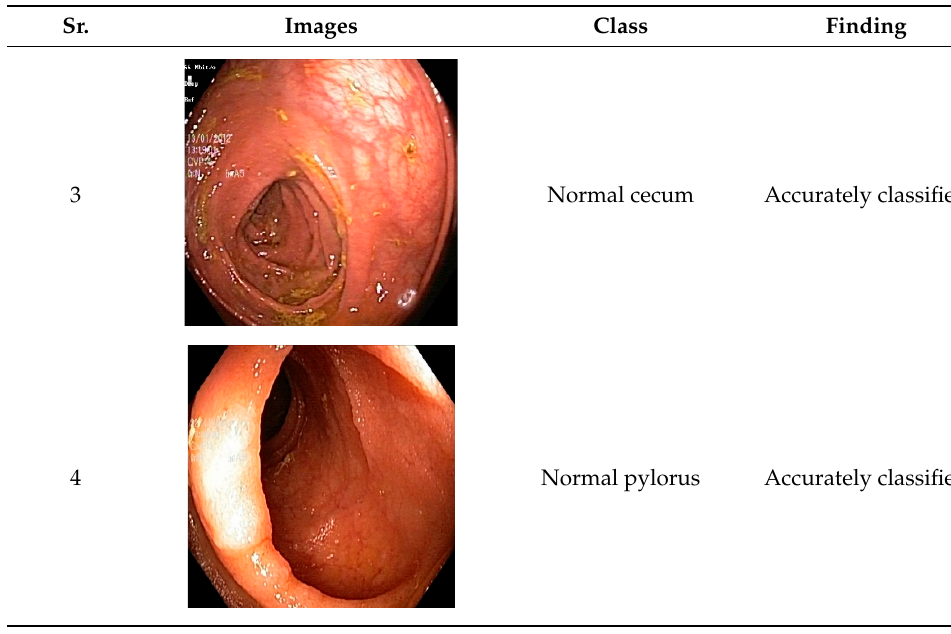
Table 9. Comparison of proposed technique with state-of-the-art